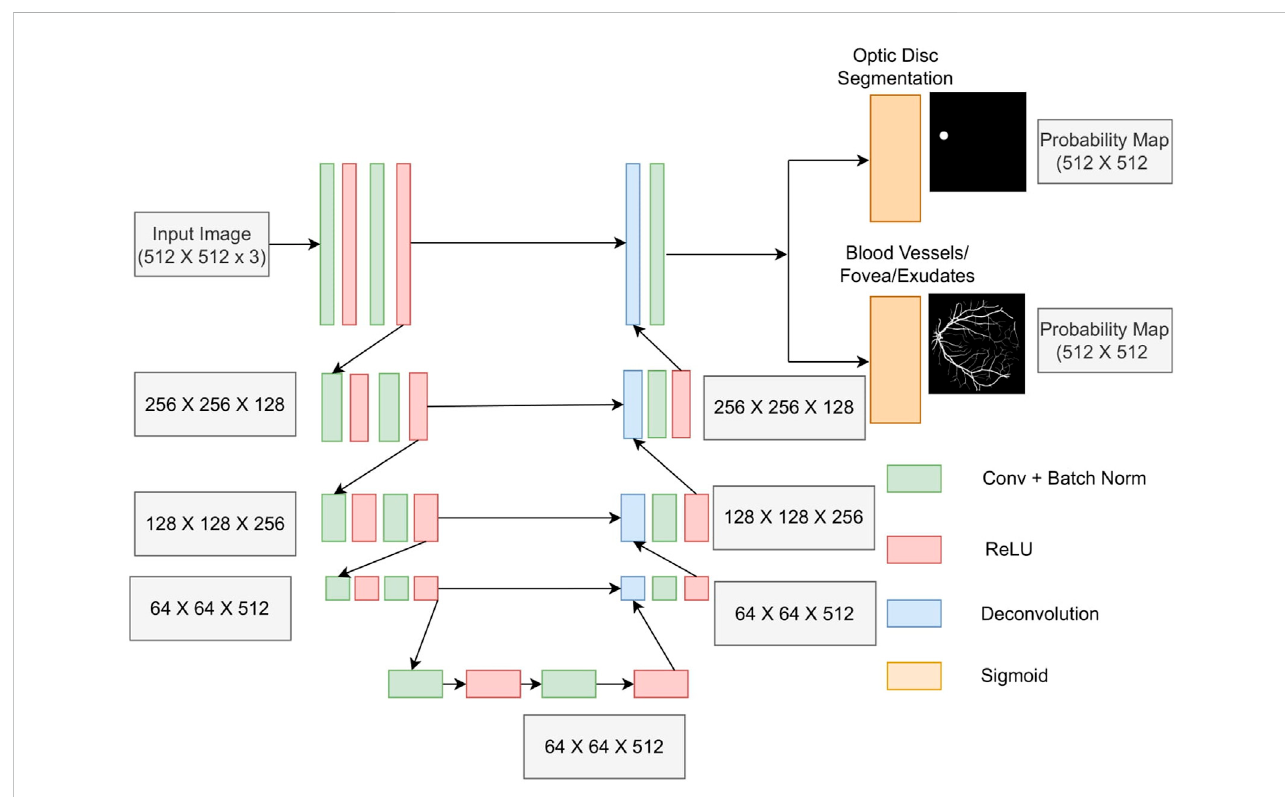
FIGURE 3 Architecture of the proposed multi-tasking U-Net